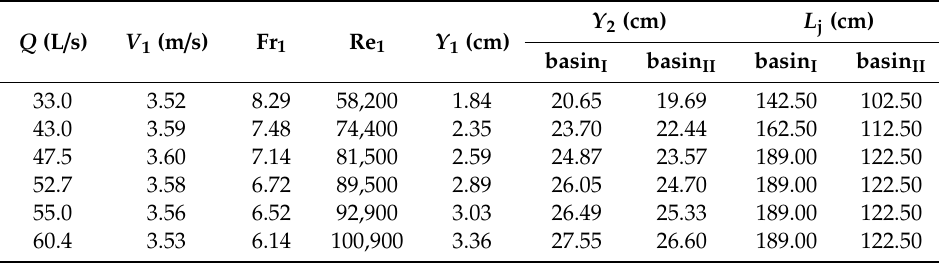
Table 1. Experimental parameters in two dissipation